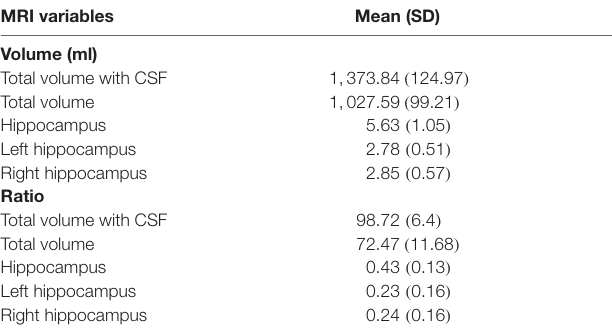
TABLE 2 | Magnetic resonance imaging variables of EOD